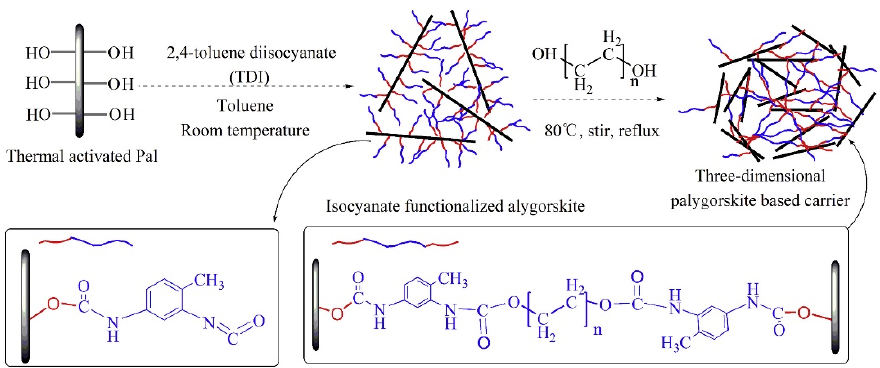
Figure 20. TDI-HO-Pal formation process [152]. Reproduced with permission from Elsevier.